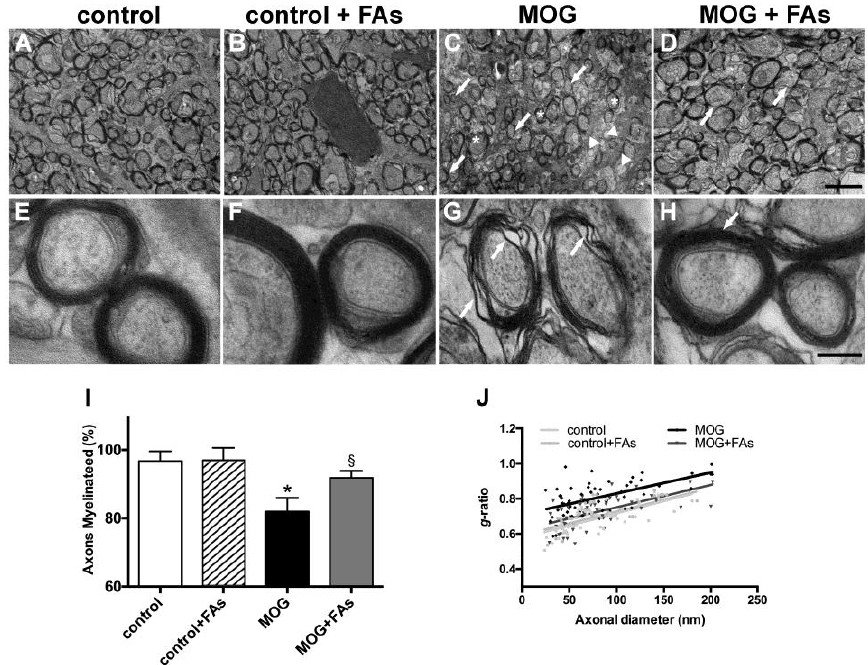
Figure 4. Dietary supplementation with FAs counteracts MOG-induced optic nerve demyelination. Representative electron micrographs of the optic nerves in control mice without ( A ) or with ( B ) FAs supplementation, MOG-treated mice ( C ), and MOG-treated mice with FAs supplementation ( D ). Calibration bar 2 µ m. Higher-magnification micrographs are shown in ( E ) (control mice), ( F ) (control mice with FAs supplementation), ( G ) (MOG-treated mice), and ( H ) (MOG-treated mice with FAs supplementation). Calibration bar, 200 nm. ( I ) Quantification of myelinated axons. Data are shown as the mean ± S.E.M. ( n = 5 for each experimental group) * p < 0.001 versus control, § p < 0.01 versus MOG (One way ANOVA followed by the Newman–Keuls multiple comparison post-hoc test). White bars, control mice; black bars, MOG-treated mice; grey bars, MOG-treated mice with FAs supplementation. ( J ) Analysis of mean g -ratio, the ratio of the inner axonal diameter to the total outer diameter (two-way ANOVA followed by Bonferroni’s multiple comparison post-test).